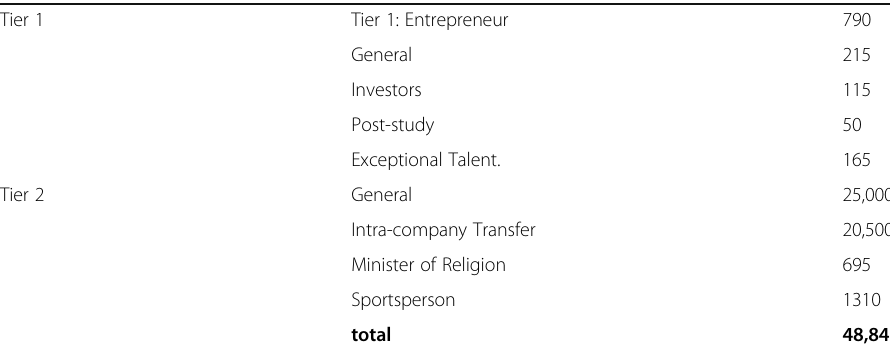
Table 4 Newly arrived HSMs in UK (2018) Tier